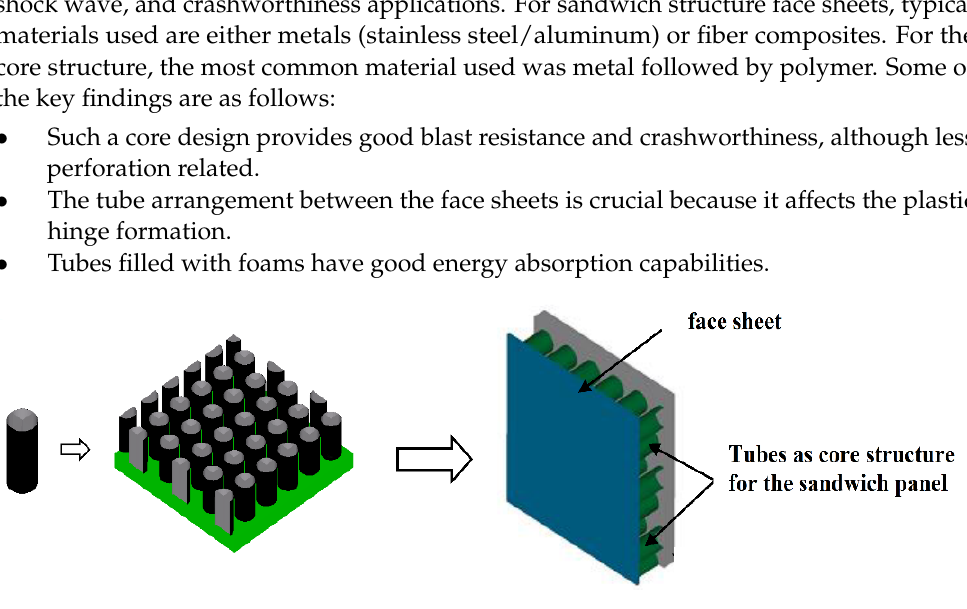
Figure 7. Example of tubular sandwich structure. Table 7. Sandwich structure with tubular core.